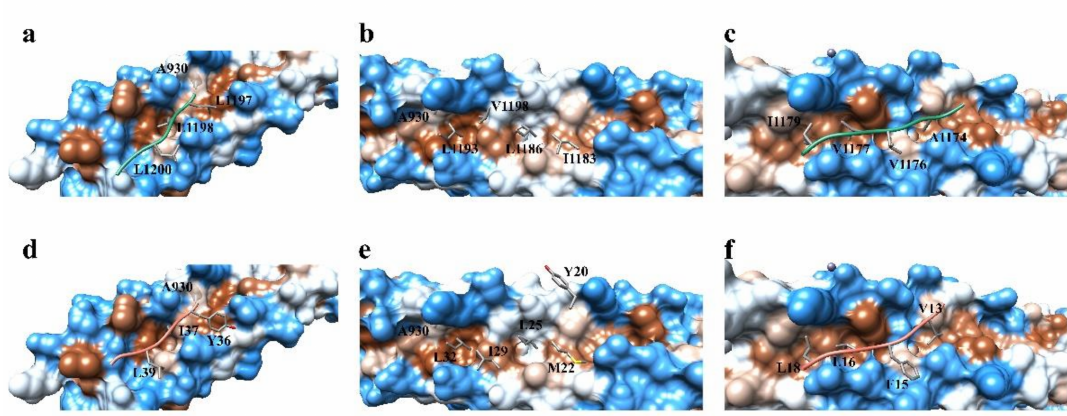
Figure 5. Hydrophobic interactions occurring between SARS-CoV-2 HR1 WT domain and HR2 and SARS-CoV-2 WT HR1 and EK1 peptide. HR2 and EK1 residue side chains are shown as either ribbon or side chains. The HR1 domain of the SARS-CoV-2 is shown as a hydrophobic surface where blue color indicates hydrophilic regions and brown color indicates hydrophobic regions. The white color indicates regions neither strongly hydrophilic nor hydrophobic. ( a ) HR1 of SARS-CoV-2 WT domain (surface) interactions with hydrophobic residues on the C terminal region of HR2 of SARS-CoV-2 WT domain (green) which flanks the core alpha helix. ( b ) HR1 of SARS-CoV-2 WT domain (surface) interactions with hydrophobic residues in the helix region of HR2 domain (side chains only) of SARS-CoV-2 WT. ( c ) HR1 of SARS-CoV-2 WT domain (surface) interactions with hydrophobic residues on the N terminal region of WT SARS-CoV-2 HR2 domain (green) which flanks the core alpha helix. ( d ) HR1 of SARS-CoV-2 WT domain (surface) interactions with hydrophobic residues on the C terminal region of EK1 peptide (salmon) which flanks the core alpha helix. ( e ) HR1 of SARS-CoV-2 WT domain (surface) interactions with hydrophobic residues in the helix region of EK1 peptide (only side chains shown) of SARS-CoV-2 WT. ( f ) HR1 of SARS-CoV-2 WT domain (surface) interactions with hydrophobic residues on the N terminal region of EK1 peptide (salmon) which flanks the core alpha helix.